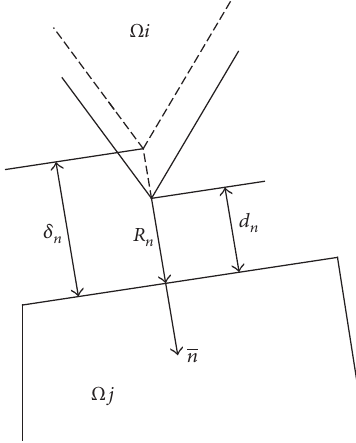
Figure 2: Model of normal contact